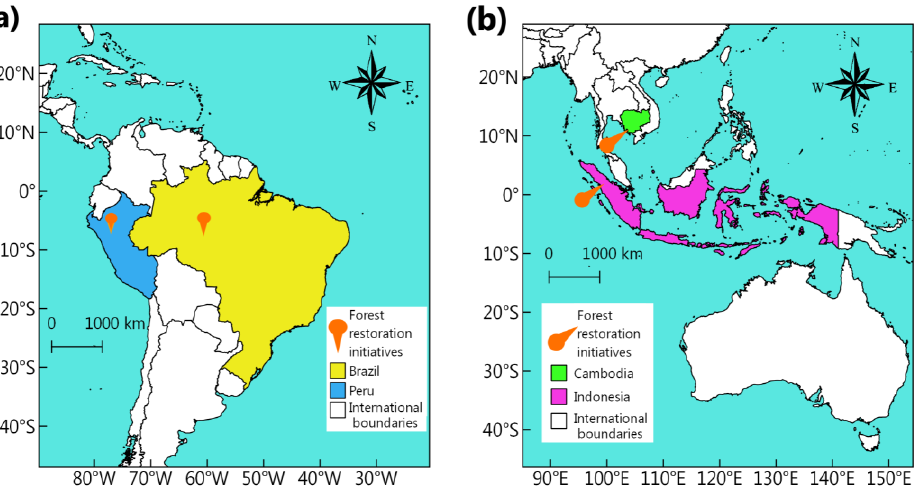
Figure 1. Representation of the study area. The orange pin symbols are close to the forest restoration initiatives visited in 2018 and 2019. ( a ) Brazil and Peru in South America. ( b ) Cambodia and Indonesia in Southeast Asia.